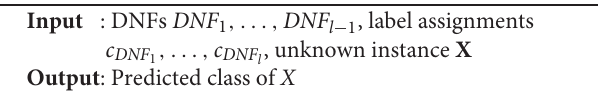
Algorithm 1 | Cascaded DNF